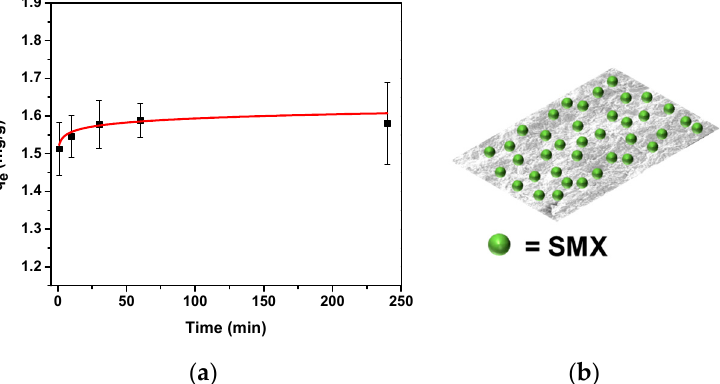
Figure 8. Adsorption capacity of TMPES and P4VP-PEO-modified CNFs films as a function of time ( a ), with a representation of the superficial adsorption of SMX ( b ).